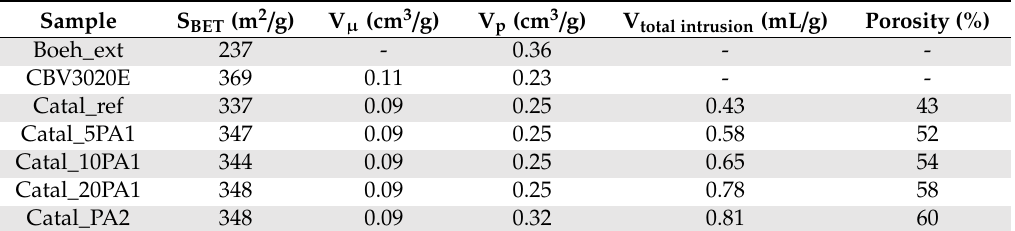
Table 1. Summary of the structural properties of as-prepared